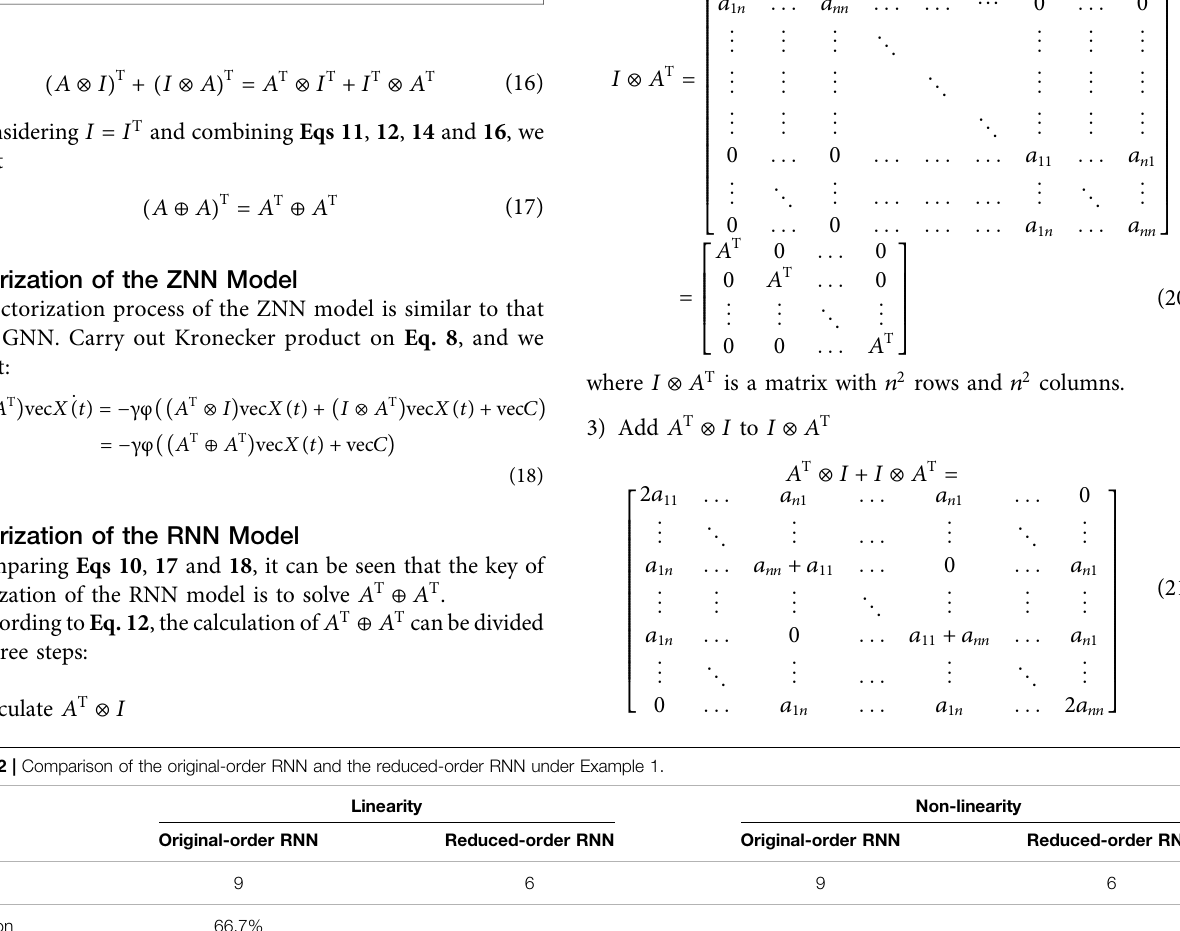
FIGURE 2 | Circuit schematics which realizes GNN.